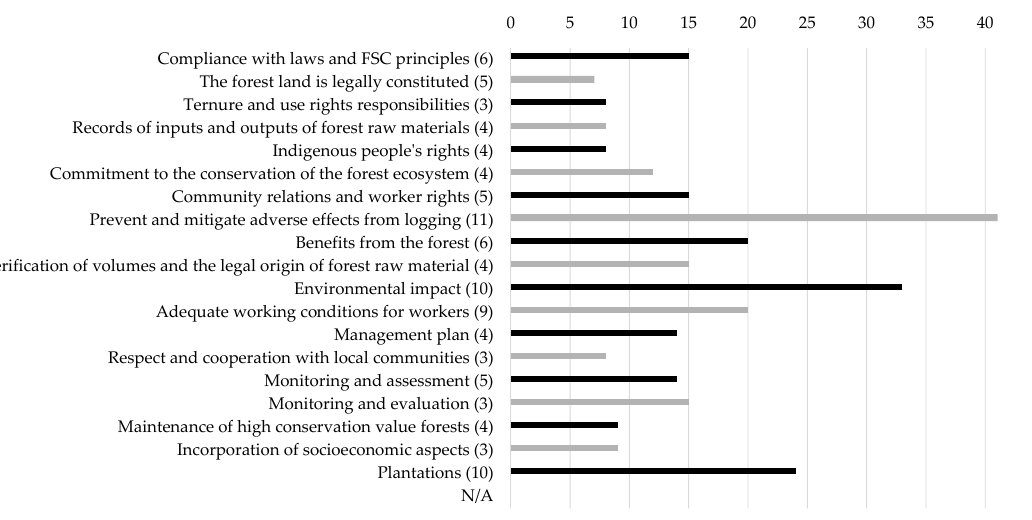
Figure 2. Certification assessment requirements by FSC and MFCS. Interpretation: FSC principle 1: “Compliance with Laws and FSC Principles” is supported by 6 criteria (number given in parentheses).